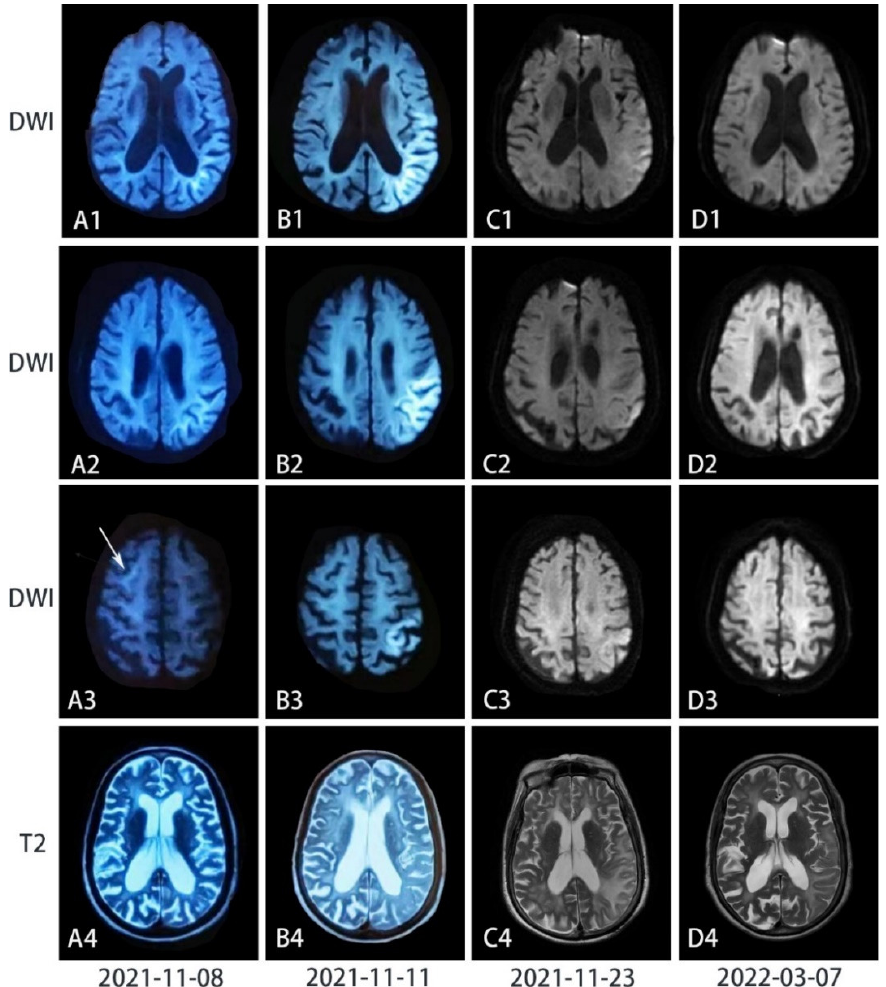
Figure 1. Chronological series of T2-weighted and diffusion-weighted images (DWI) images of the patient’s brain. ( A ) Seven days after the disease onset when she had cognitive impairment, mixed aphasia, and muscle weakness, DWI showed curvilinear periventricular hyperintensity, while the T2-weighted image showed diffuse brain atrophy. ( B ) Two days after her symptoms exacerbated when she could be only bedridden, curvilinear lesions had transformed into confluent high-intensity lesions on DWI along the cortex in the temporal occipitoparietal lobe (in B1), where severe encephalopathy was also observed on the T2-weighted images. However, curvilinear hyperintensity in A3 disappeared. ( C ) Half a month after the peak and the treatment of pulse intravenous methylprednisolone, most high-intensity signals on DWI were eliminated but leukoencephalopathy and cortical edema on the T2-weighted scan were exacerbated. ( D ) Four months after the symptoms onset, high-intensity signals on DWI have vanished, while hyperintensity reduced with improved brain edema on T2-weighted images.